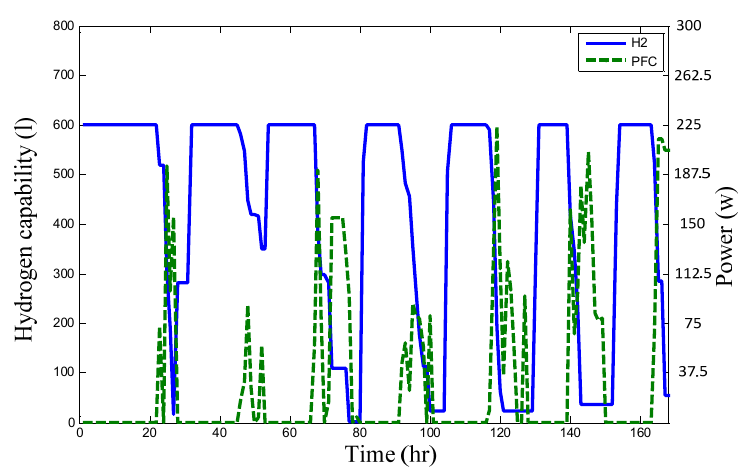
Figure 11. The curves of the hydrogen capability and fuel cell power in the first week of June.